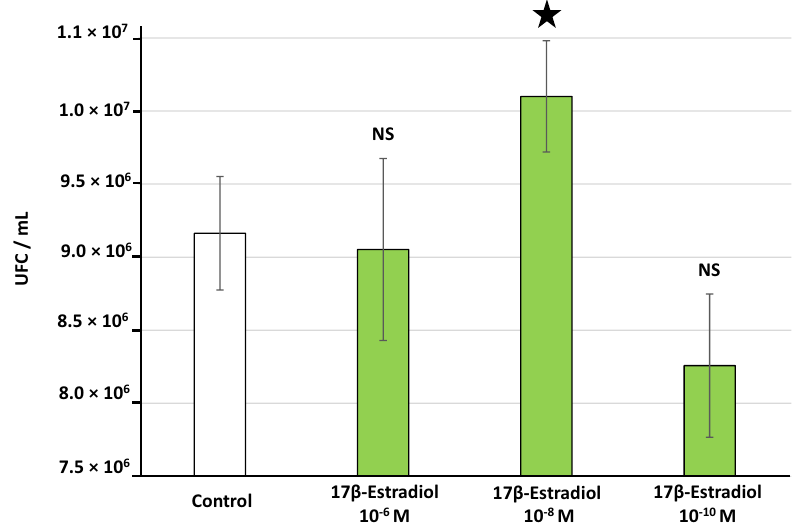
Figure 5. Effect of 17β-estradiol on the adhesion potential to VK2/E6E7 human vaginal cells of Lactobacillus crispatus CIP104459 grown in De Man, Rogosa and Sharpe (MRS) medium. Values are the means ± SEM of three independent studies. ( NS not significant; * = p <